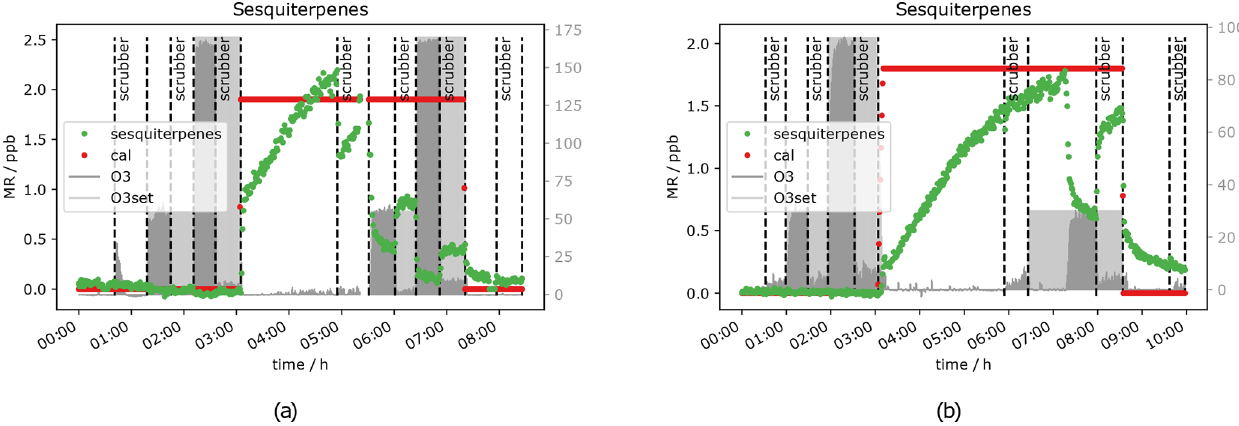
Figure 15. Sesquiterpene mixing ratio with and without scrubber at different O 3 mixing ratios when 2ppb sesquiterpenes were introduced to the system: (a) 0% RH and (b) 50%